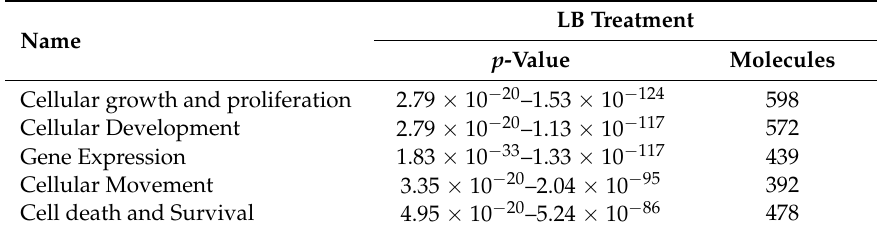
Table 7. Top gene molecular and cellular functions associated with lactobacilli treatment—IPA analysis.